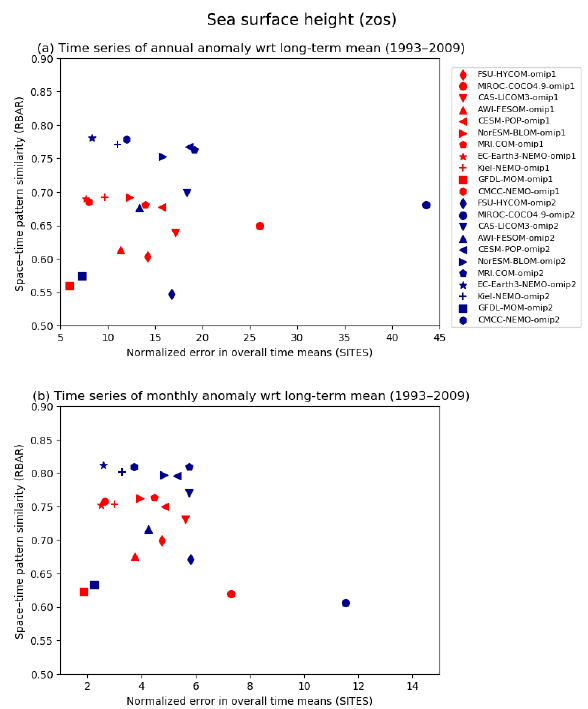
Figure E7. Same as Fig. E6 but for SSH. The reference SSH dataset is from